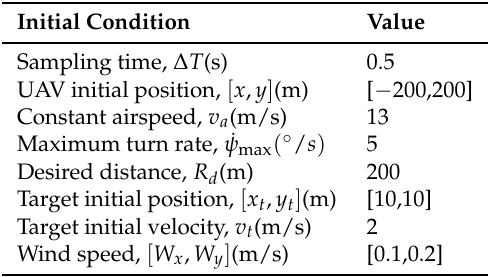
Table 1. Parameters of target tracking, UAV: unmanned aerial vehicle.